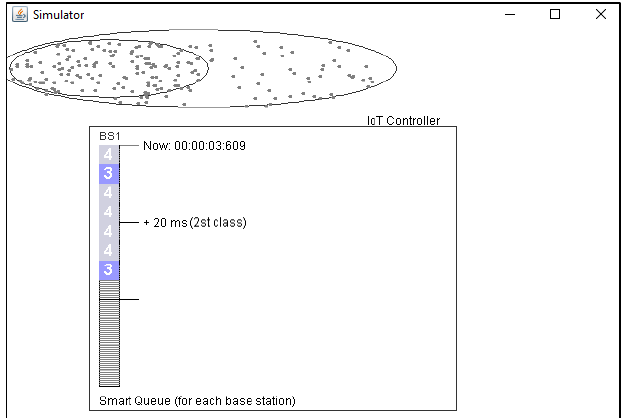
Figure 10. Simulation organization of the LTE/NB-IoT network.